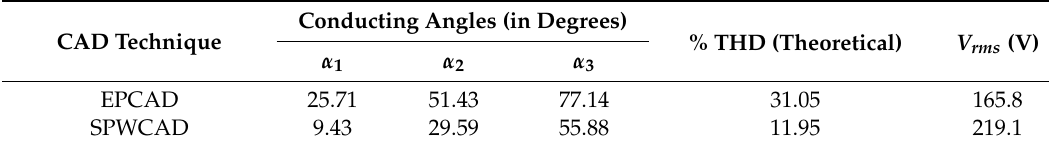
Table 6. Conducting angles, theoretical output phase voltage THD, and V rms values for a seven-level DCLCHB inverter (m =